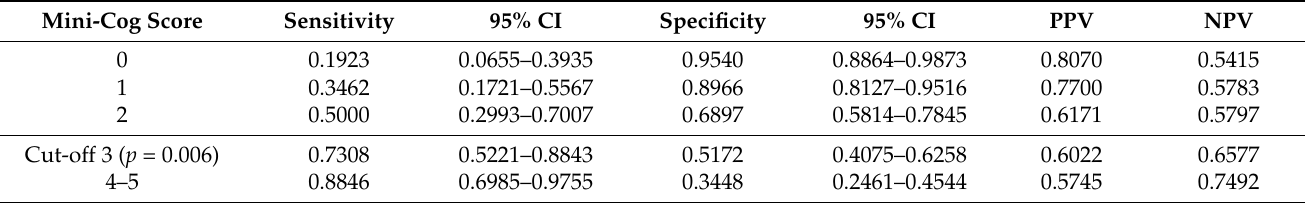
Table 3. Sensitivity and specificity of Mini-Cog test in predicting postoperative delirium.